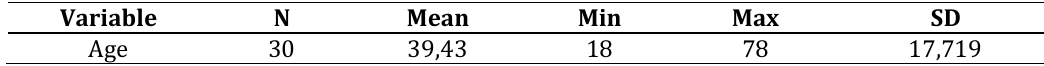
The age distribution of the study participant Variable